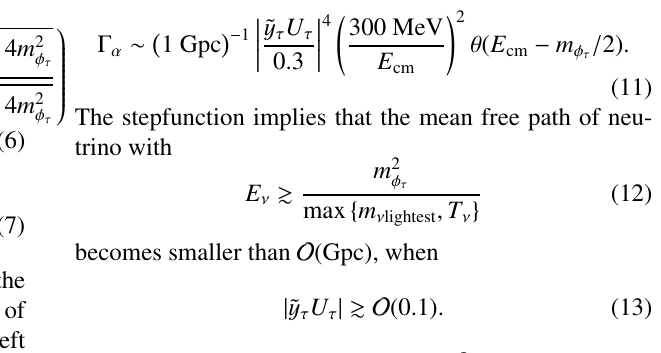
Figure 1. The mean free path for the neutrino in mass eigenstate α as a function of energy. We take M ψ = m φ = 0 . U τ ˜ y τ | |